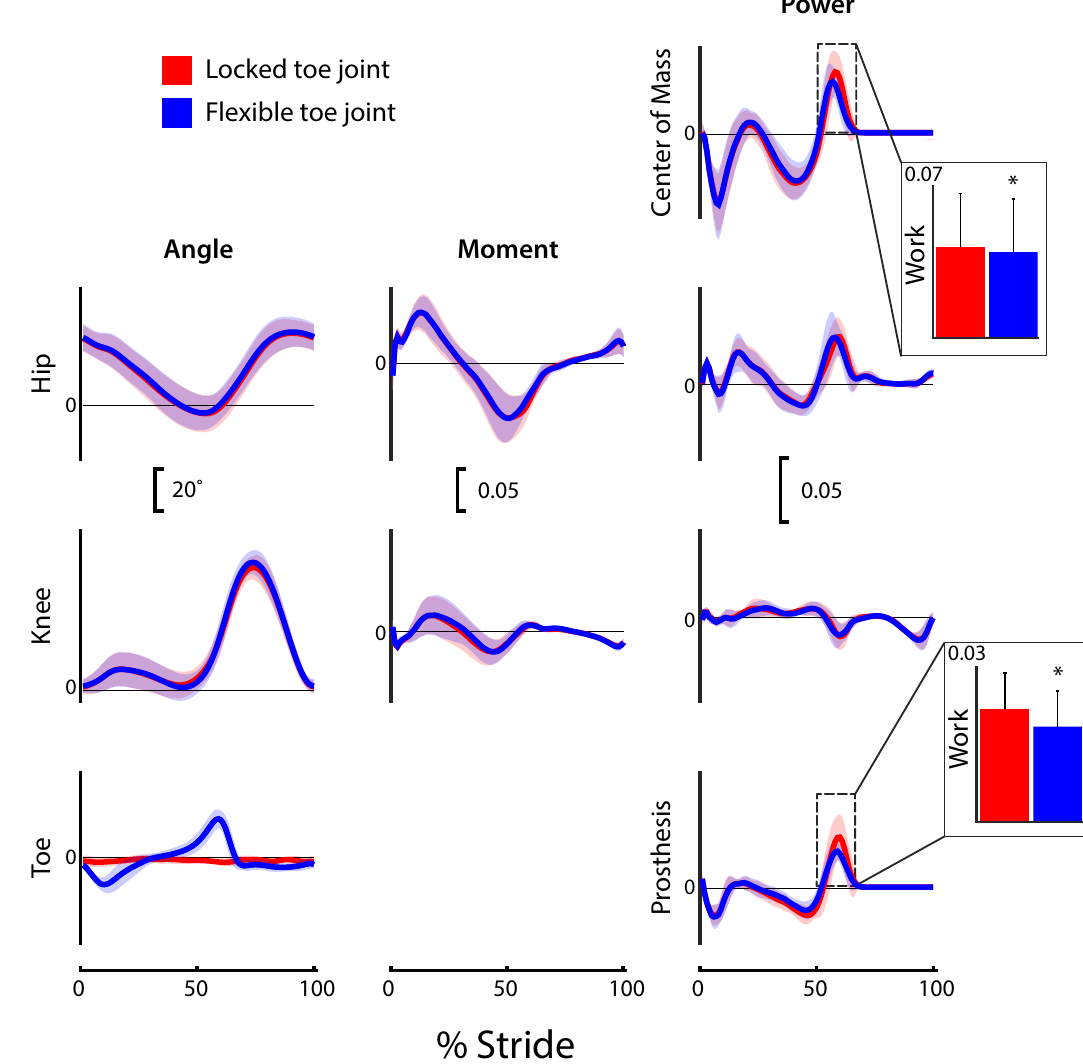
Figure 3. Prosthetic limb joint, center of mass and prosthesis dynamics for participants ( N = 9) walking in a passive prosthesis with (i) a Flexible (dark blue line) and (ii) a Locked (light red line) toe joint configuration. Kinematic (angles) and kinetic (moments, powers) data were cropped into strides using ipsilateral heel strikes of the prosthetic limb. Positive prosthesis work and center of mass work were computed during Push-Off phase only (defined by center of mass power traces). Data are presented as mean ± standard deviation (shaded regions). Using group mean re-dimensionalization constants, 0.05 corresponds to 0.47 Nm kg −1 /J kg −1 for moments and work, and 1.50 W kg −1 for